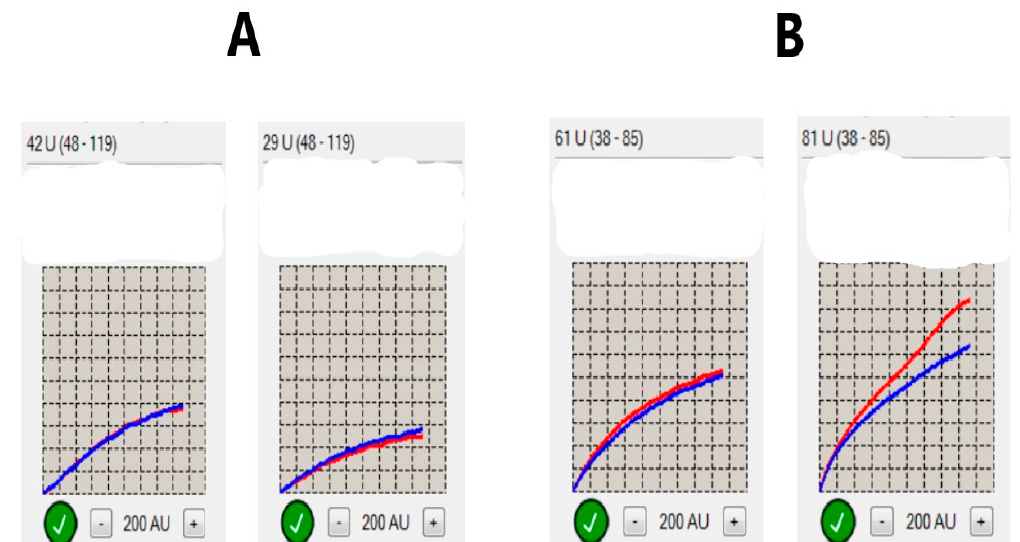
Figure 1. Changes of platelet reactivity over time. ( A ) A sample of favorable changes in platelet reactivity. On the left side—normal initial platelet reactivity value (42 U—area under the curve units). On the right side—48 h later—decrease in platelet reactivity to 29 U; the difference between the two assessments is 13 U—more than a median difference (5U). ( B ) A sample of unfavorable changes in platelet reactivity. On the left side—high initial platelet reactivity value (61 U). On the right side—48 h later; an increase in platelet reactivity to 81 U. This sample meets our criteria for the third definition of clopidogrel resistance (high initial value combined with unfavorable dynamics). The final value in AUC is the average between the results obtained in two pairs of electrodes (marked as red and blue lines).